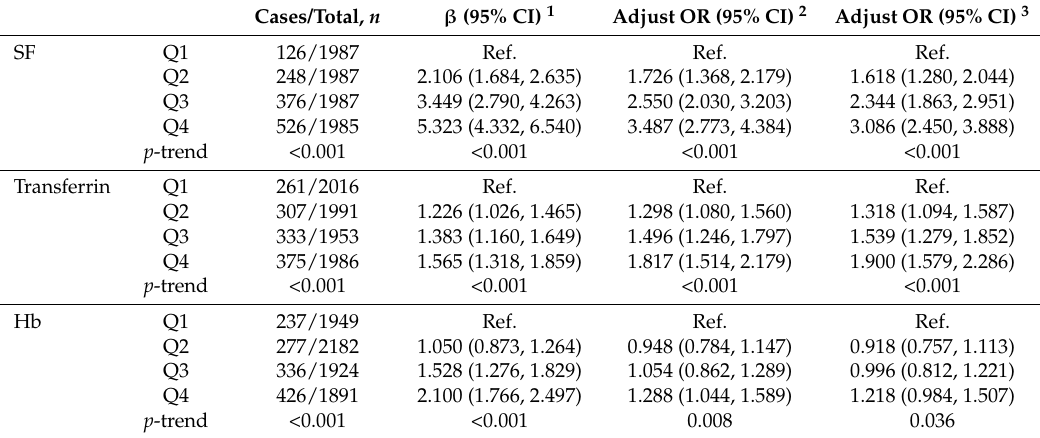
Table 3. Multilevel-adjusted associations of SF, transferrin, and Hb levels with the risk of HU in Chinese adult population ( n =